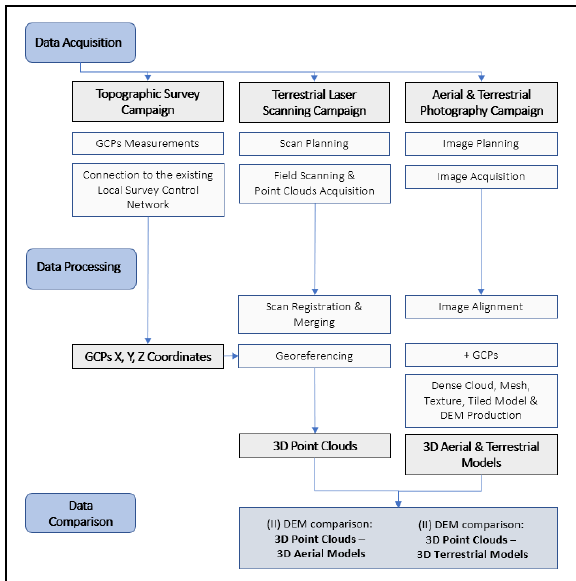
Figure 2 . Overall workflow of the presented methodology.